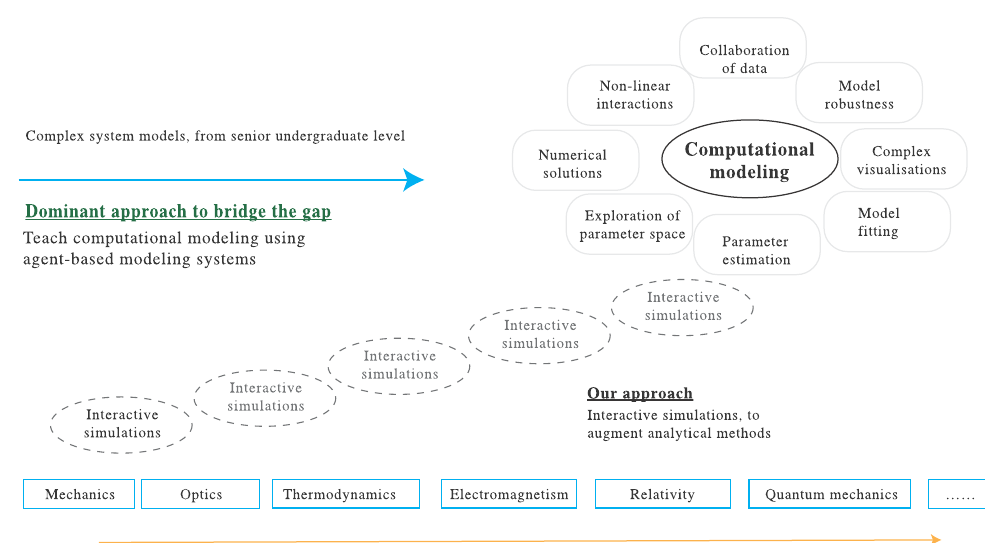
FIG. 12. Students are taught topics like mechanics, optics, thermodynamics, etc., as sequential modules, before moving to advanced topics like quantum mechanics (trajectory shown at the bottom of the figure). Introducing computational modeling (top right) in the senior undergraduate years introduces a whole set of new and unfamiliar practice elements, which makes physics difficult for most students. A dominant approach at this level is to teach CM using-agent based modeling (in green), which is disconnected from the core physics courses, and thus lacks pedagogical continuity and coherence. This problem is mitigated in our approach (the diagonal ovals), based on bridge simulations and numerical solutions as boundary crossing spaces. This structure creates a smoother